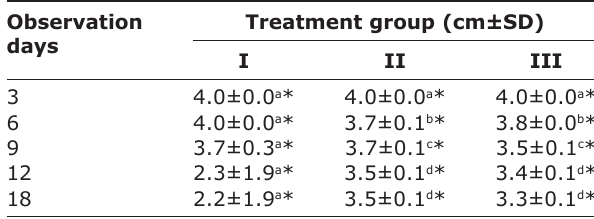
Table-3: Observation of subjective donor skin size.